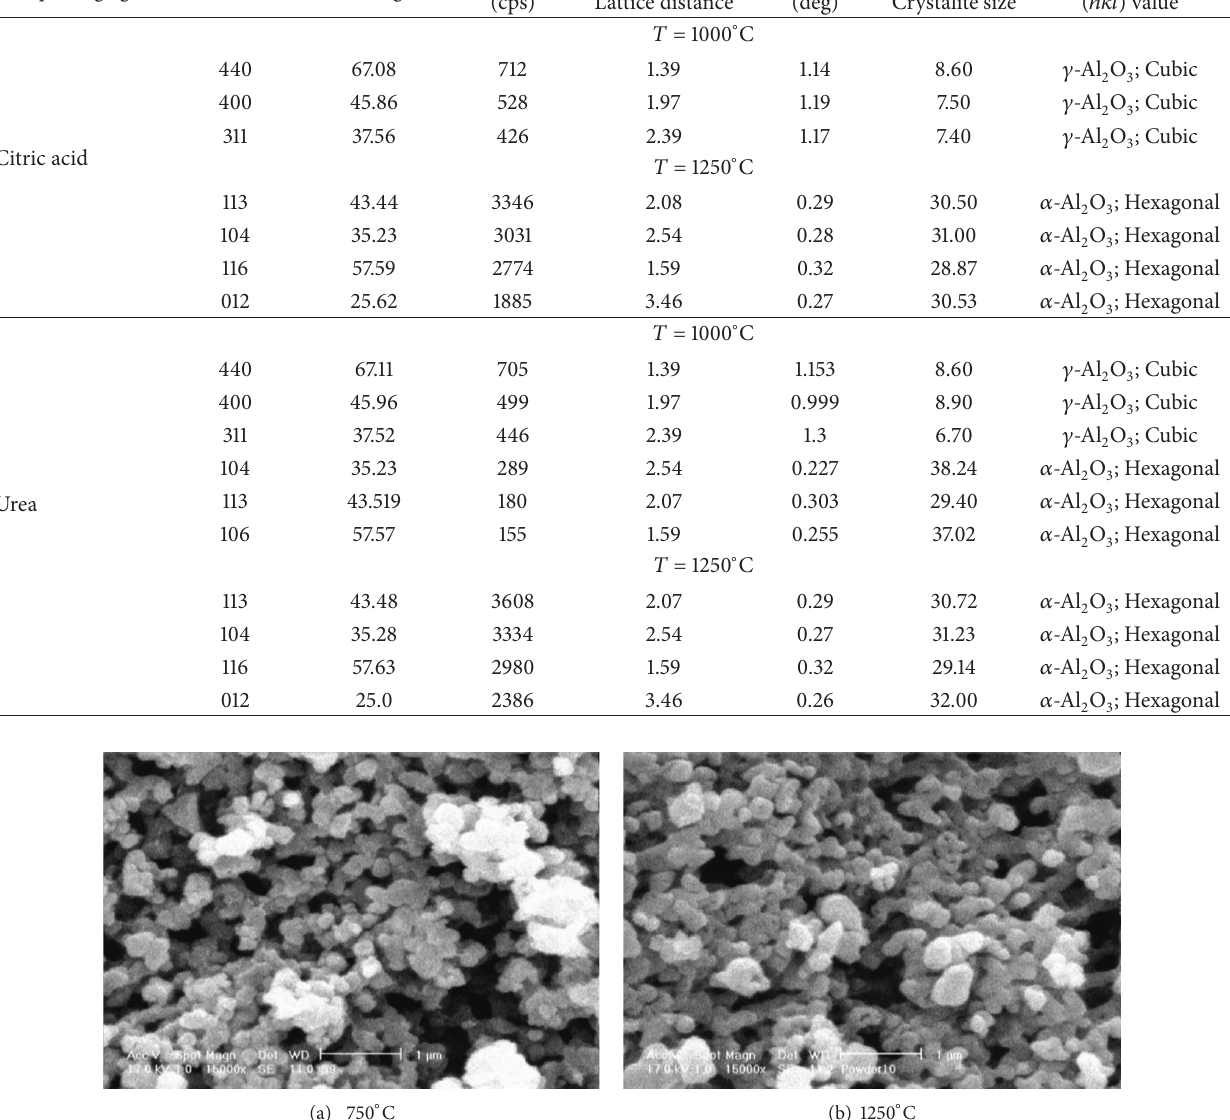
Figure 4: SEM image of Al 2 O 3 nanoparticles prepared by citric acid calcined at (a) 750 ∘ C and (b) 1250 ∘